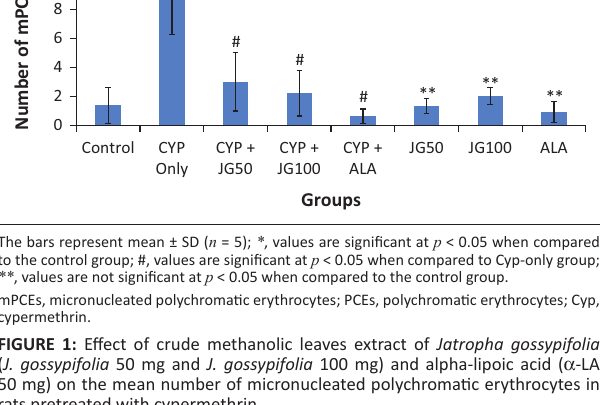
http://www.jomped.co.za